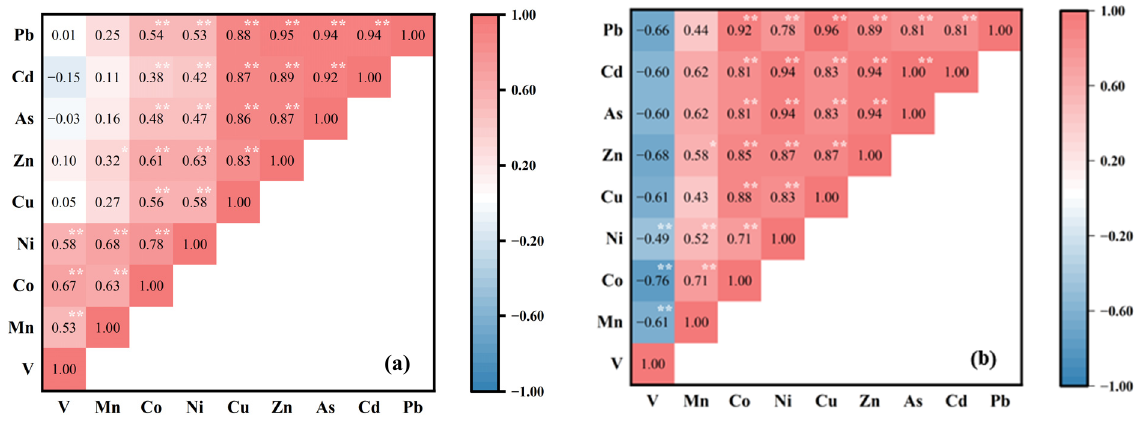
Figure 4. Spearman correlation hot map between heavy metals in soils of ( a ) surrounding area and ( b ) non-ferrous metal smelting plant (NMSP). *: probability value < 0.05; **: probability value < 0.01.